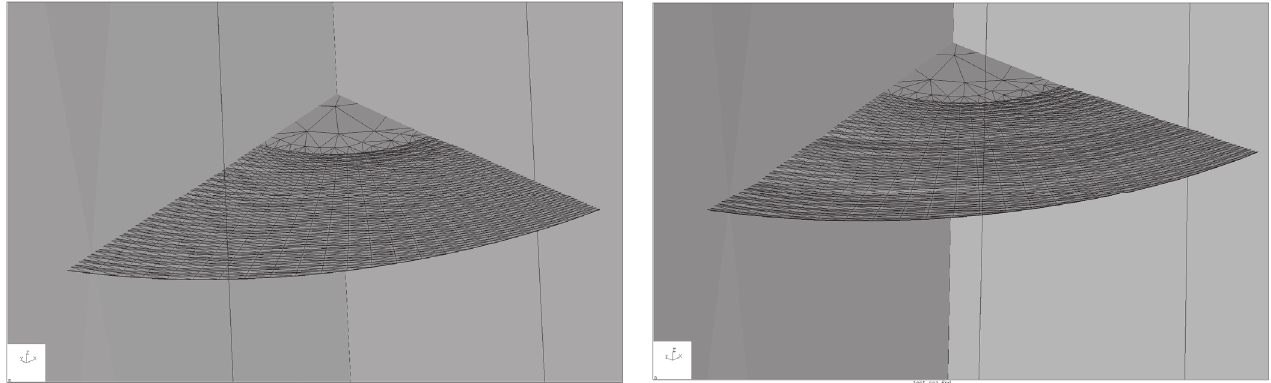
Figure 8a: Crack propagation due to LCF. Figure 8b: Crack propagation due to